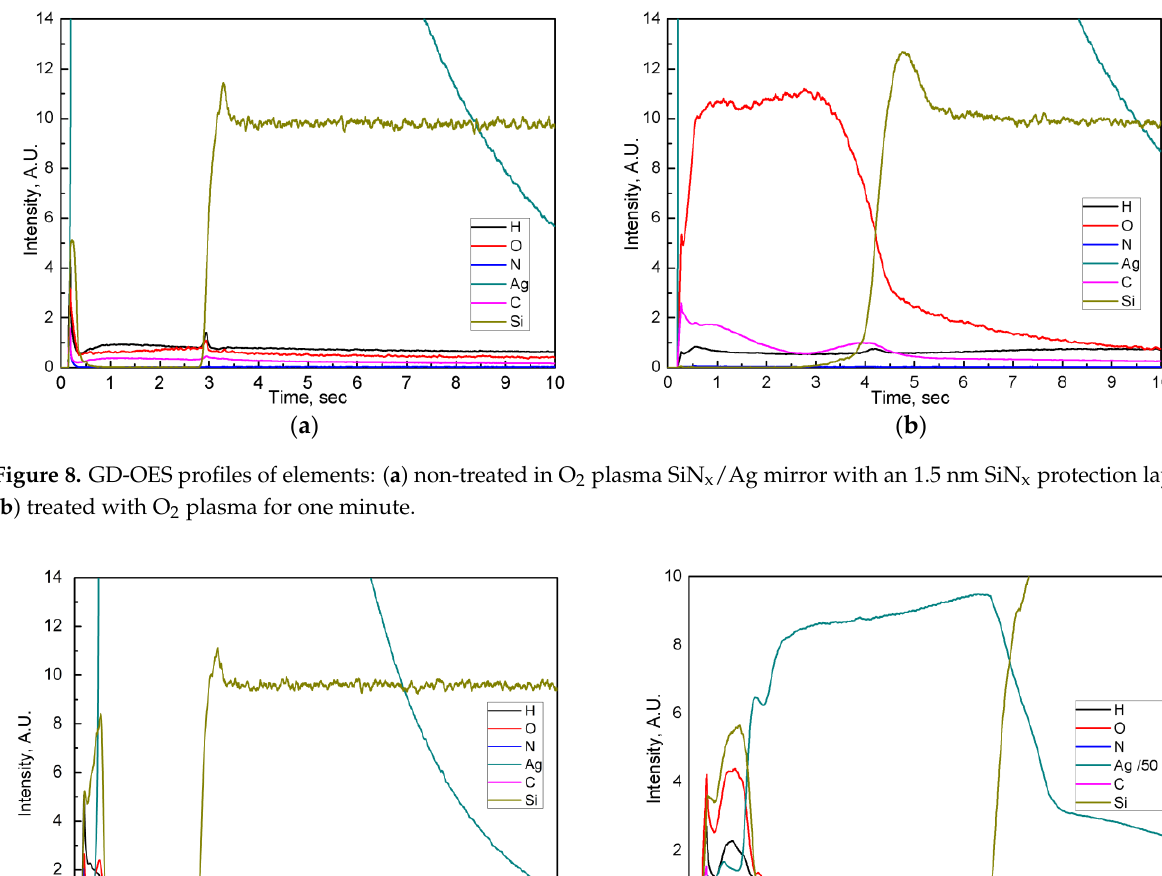
Figure 7. GD-OES profiles of the elements in a not-treated with O 2 plasma SiN x /Ag mirror. Silver signal intensity is divided by 50. The silver layer is fully covered by SiN x :H; all interfaces are resolved.